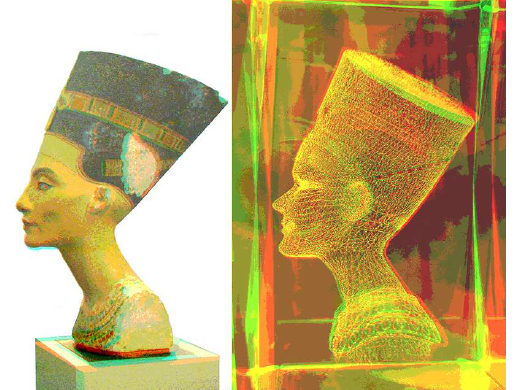
Figure 14. VITRO crystal laser engraving machine of company LOOXIS (Hannover, Germany) obviously currently pushing the 3D Technology in Cultural heritage (courtesy R.Titze, Hannover; similar: CERION) Furthermore lasered crystals even allow quasi freezing of moments of dynamic processes in 3D (e.g. in Figure 15)